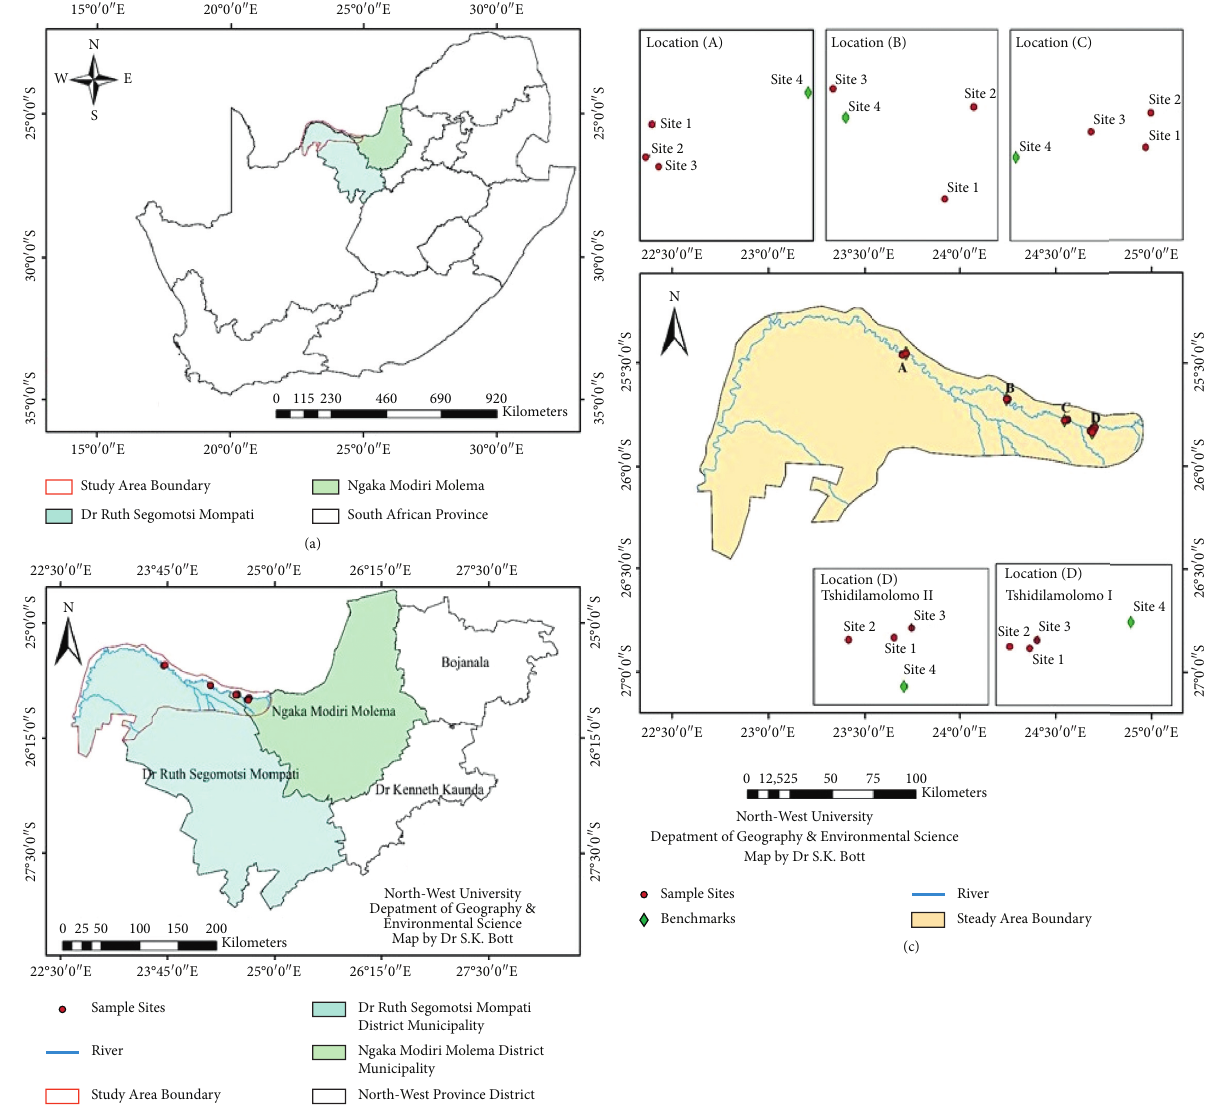
Figure 1: Map showing the location of the five study sites along the riverine system of the Molopo River in North-West Province, South